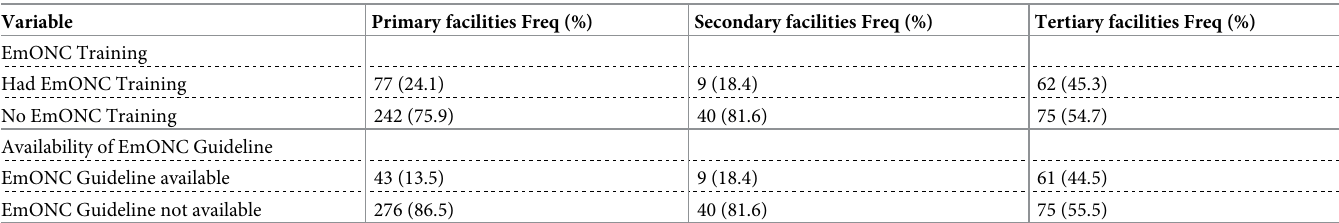
Table 6. Percentage distribution of respondents with EmONC training and guidelines in healthcare